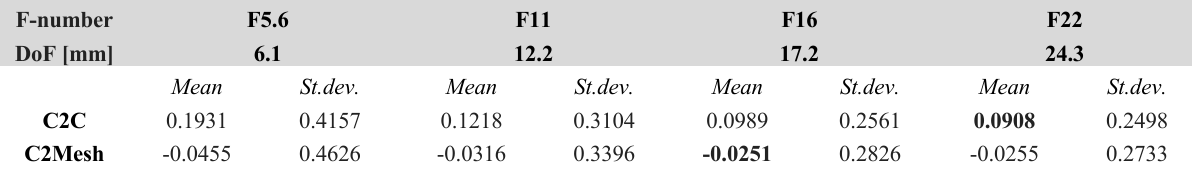
Table 1. Metric evaluation (Cloud-to-Cloud and Cloud-to-Mesh comparisons [mm]) of the dense reconstructions achieved with several aperture settings for the Moses statue (105 mm focal length, 500 mm object distance).